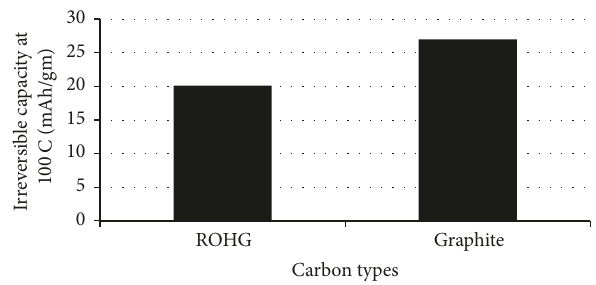
graphite show low and comparable irreversible capacity at conditioning rates ( ∼ C/2). ROHG and graphite both